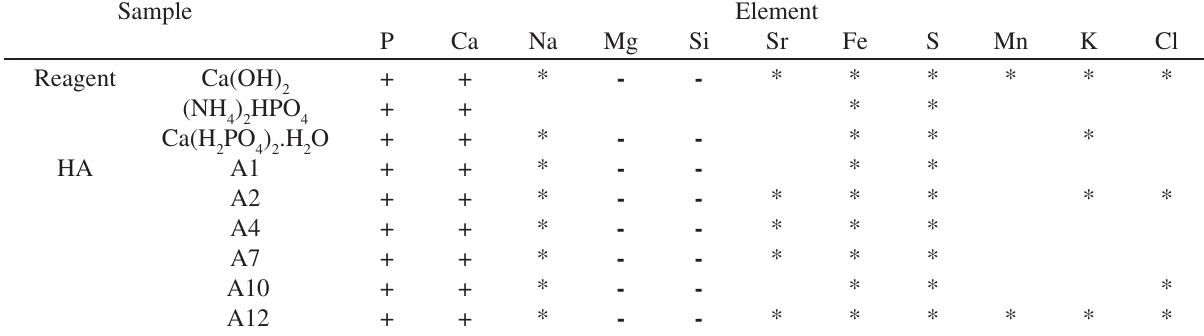
Table 2. XRF of reagents and some HA synthesized powders. Sample